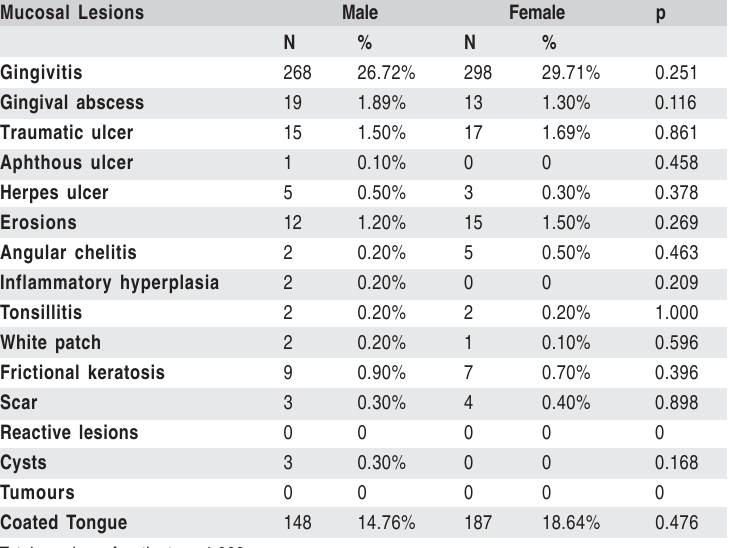
Table 2 - Oral mucosal lesions